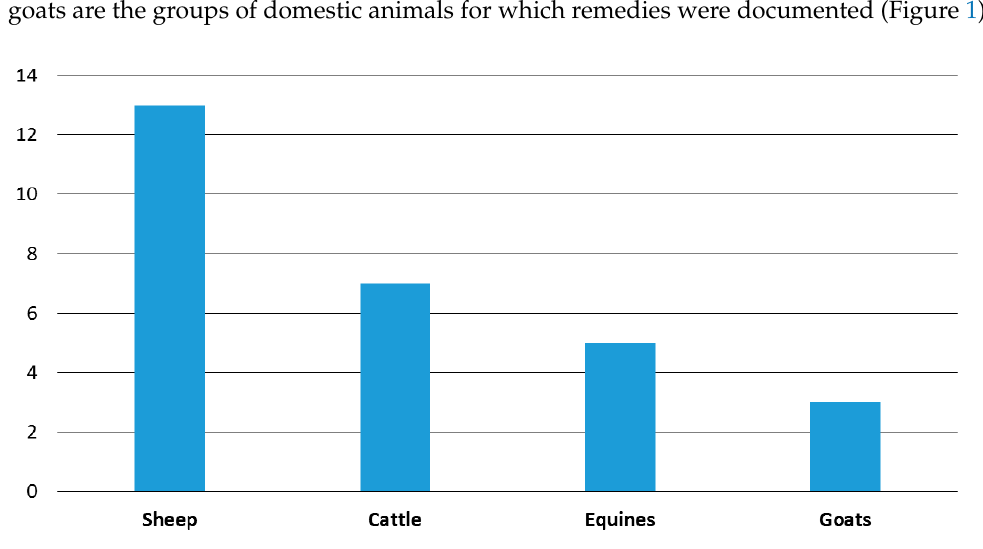
Figure 2. Number of empirical remedies documented used per disease category.